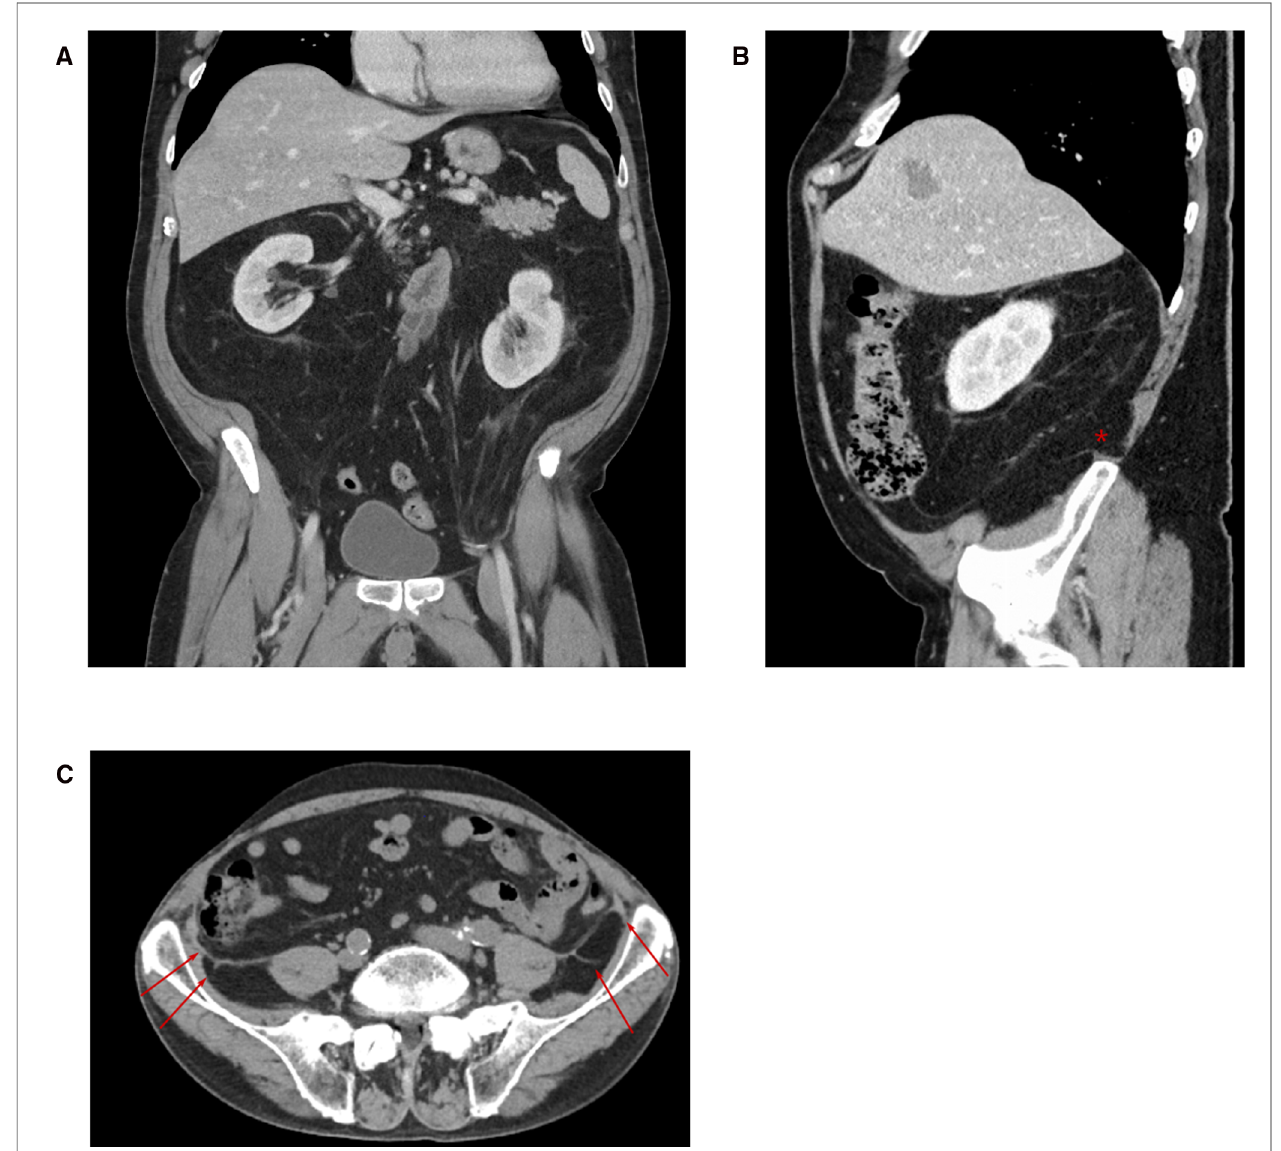
FIGURE 7 | CT imaging with coronal ( A ) and sagittal ( B ) sections through the abdomen. The pararenal fat extends into the pelvis and in this patient ultimately into the left inguinal canal like an inverted cone. An attachment of the posterior renal fascia to the transversalis fascia at the ililac crest can be seen in the sagittal section (*) and ( C ) transverse section